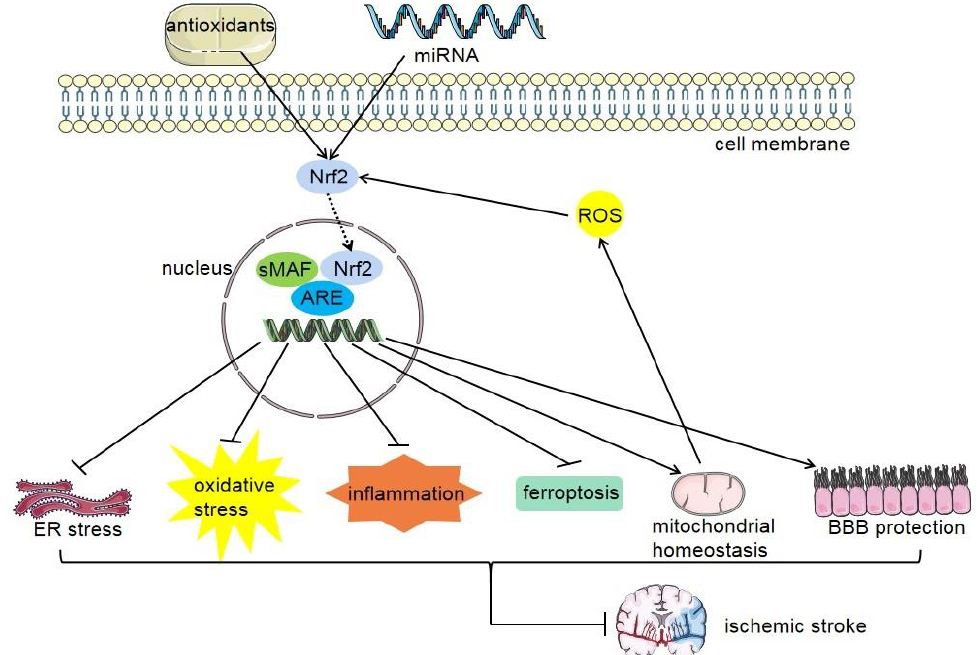
Figure 7. The beneficial impacts of Nrf2 activation on cerebral ischemia stroke. Antioxidants and miRNA can upregulate the expression of Nrf2 and then promote the expression of related target genes, which can inhibit ER stress, oxidative stress, inflammation, iron death, BBB, mitochondrial homeostasis, and brain protection. Nrf2, nuclear factor erythroid 2-related factor 2; sMAF, small musculoaponeurotic fibrosar- coma; ARE, antioxidant response element; ROS, reactive oxygen species; ER stress, endoplasmic reticulum stress; BBB, blood – brain barrier.